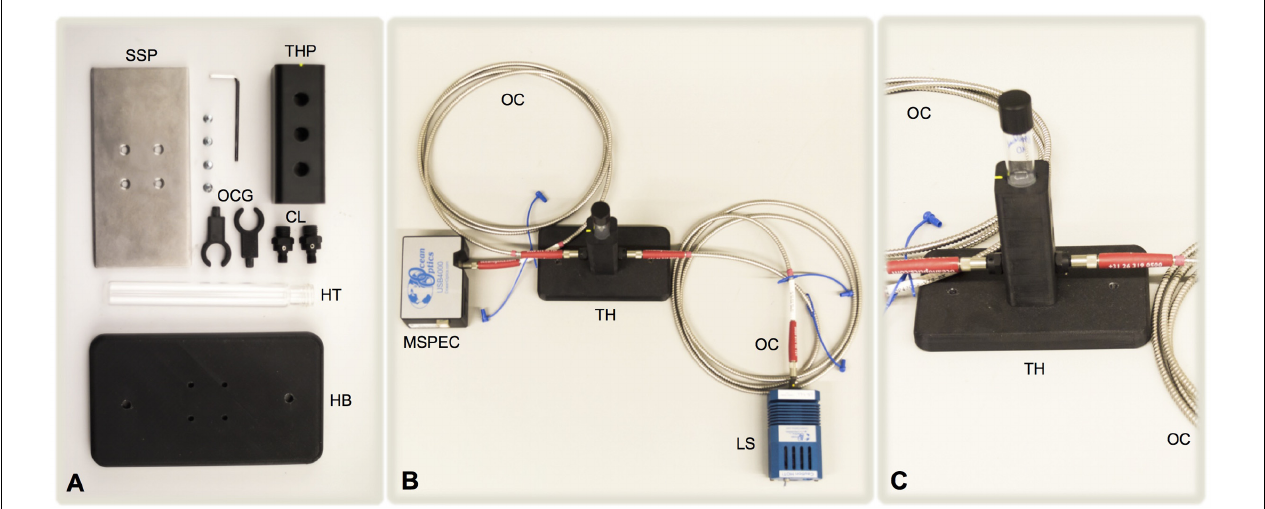
FIGURE 1 | Detailed parts of the 3D printed culture tube holder (A), the miniaturized setup used for monitoring the bacterial growth (B), and a detailed view of the tube holder (C). SSP, solid steel platform; THP, tube holder part; OCG, optical cable guides; CL, collimating lens; HT, Hungate tube; HB, holder’s base; MSPEC, miniaturized spectrophotometer; OC, optical cable; TH, tube holder; LS, light source. For sake of simplicity, the power connection to the light source and the power/data communication USB connection from the miniaturized spectrophotometer to the computer were not